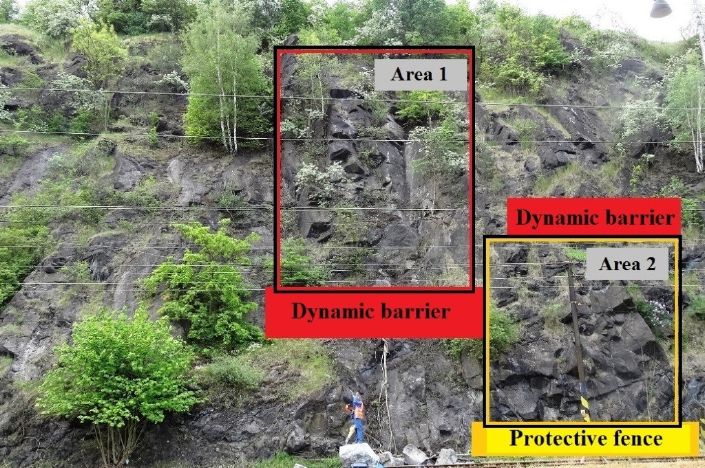
Figure 9. Locations for the placement of dynamic barriers and the protective fence in the endangered areas of the rock